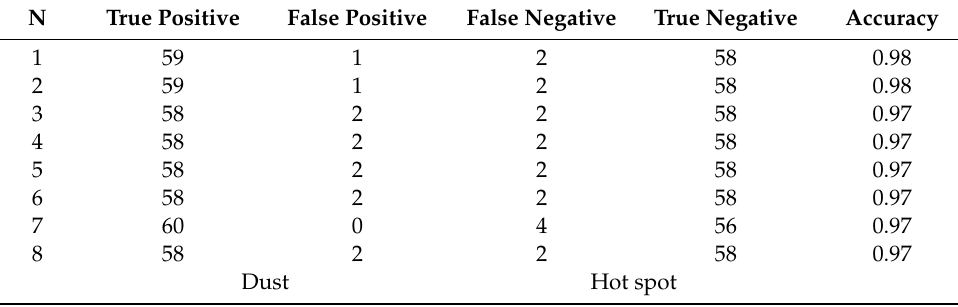
Table 3. Confusion matrix of tests without augmentation techniques.